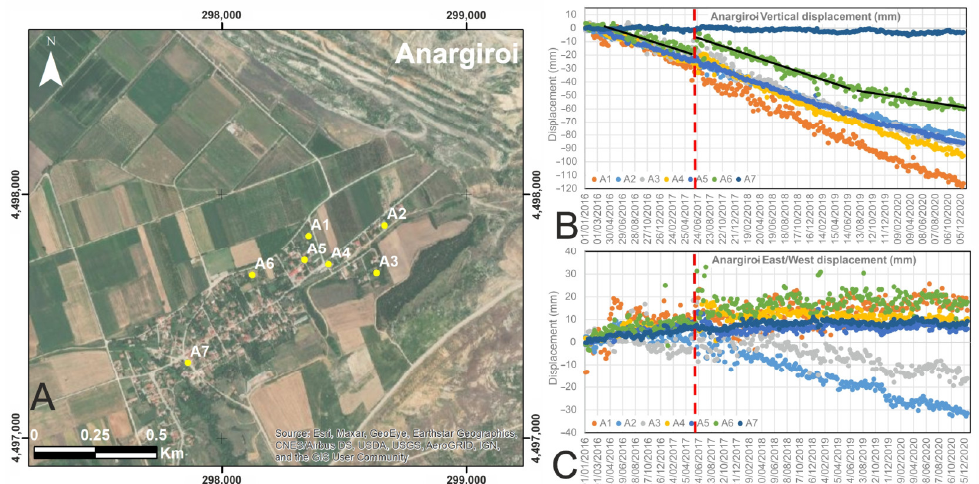
Figure 7. Spatial distribution of examined PS points ( A ) along with their displacement time series ( B , C ) at the village of Anargiroi. The dashed red line indicates the date of the mining landslide event. The trend lines added to the time series of point A6 indicate the variations of the land subsiding trend due to the draining activities before and after the occurrence of the landslide, as well as after the 2016 cessation of pumping from the wells located between the village and the open pit. Point A6 was selected as it clearly presents the disturbance caused by the landslide as well as the slight reduction of the deformations after the end of the end of the draining activities.